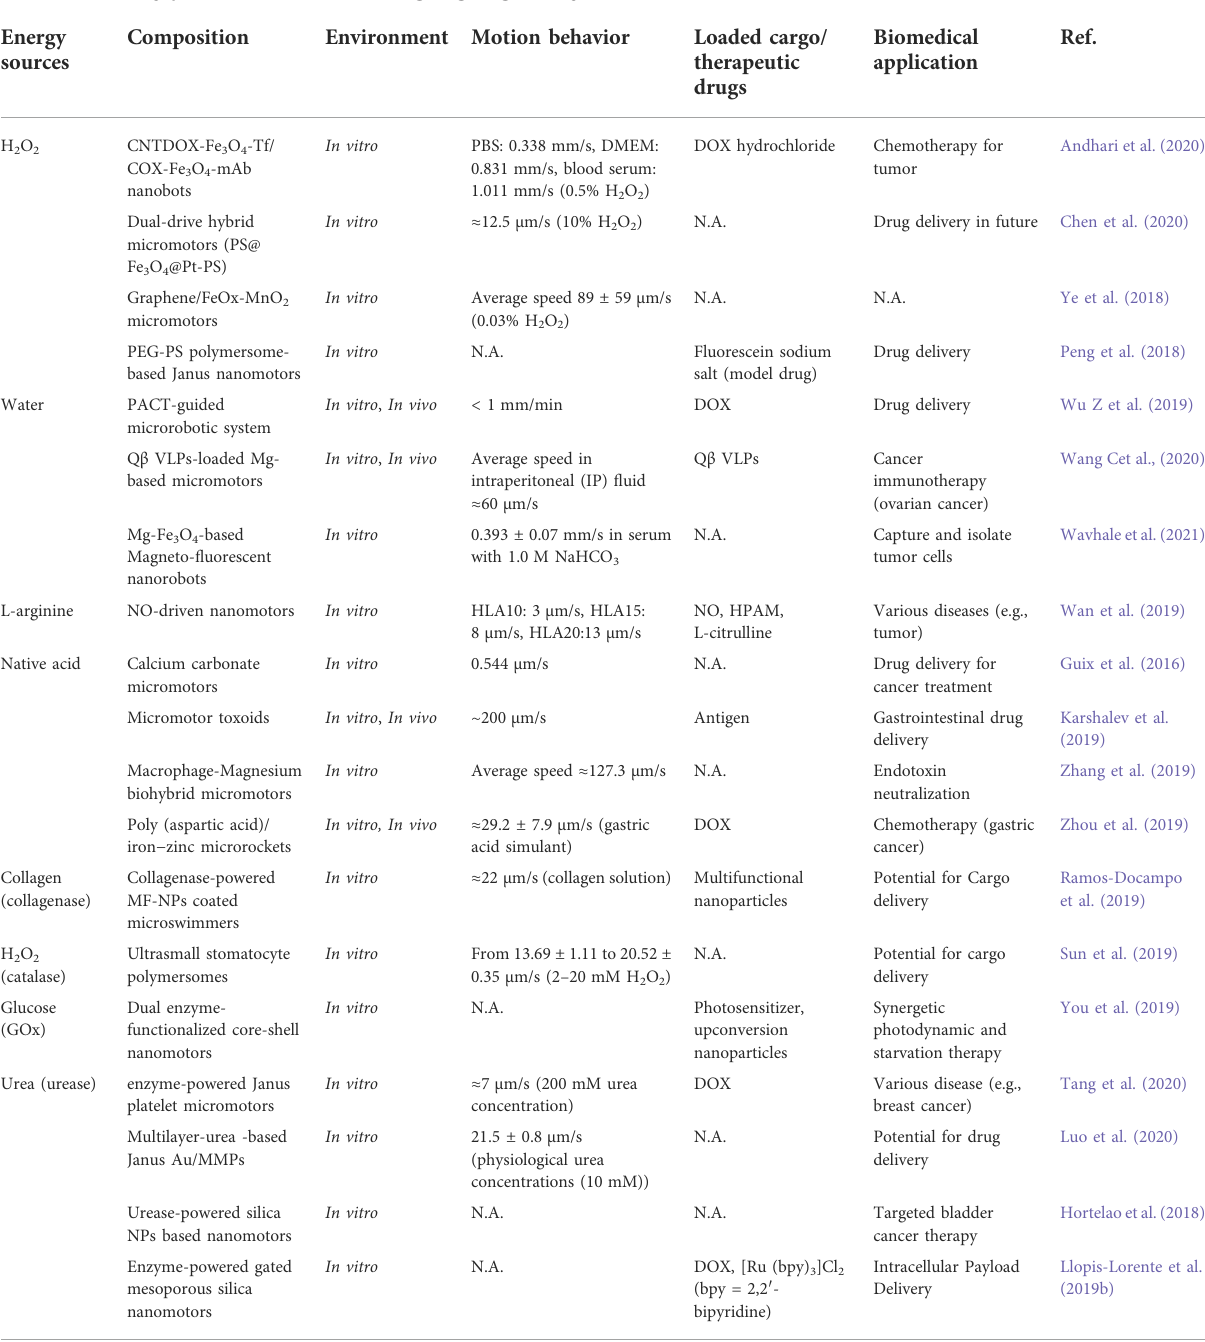
TABLE 1 Chemically-powered MNRs for motile-targeting drug